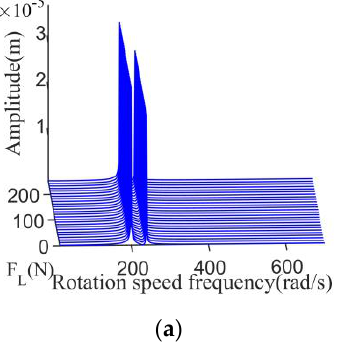
Figure 13. Waterfall plots of frequency responses under different load. ( a ) At disk 1 of the conven- tional MSDS. ( b ) At disk 1 of the nonlinear MSDS. ( c ) At disk 4 of the nonlinear MSDS.